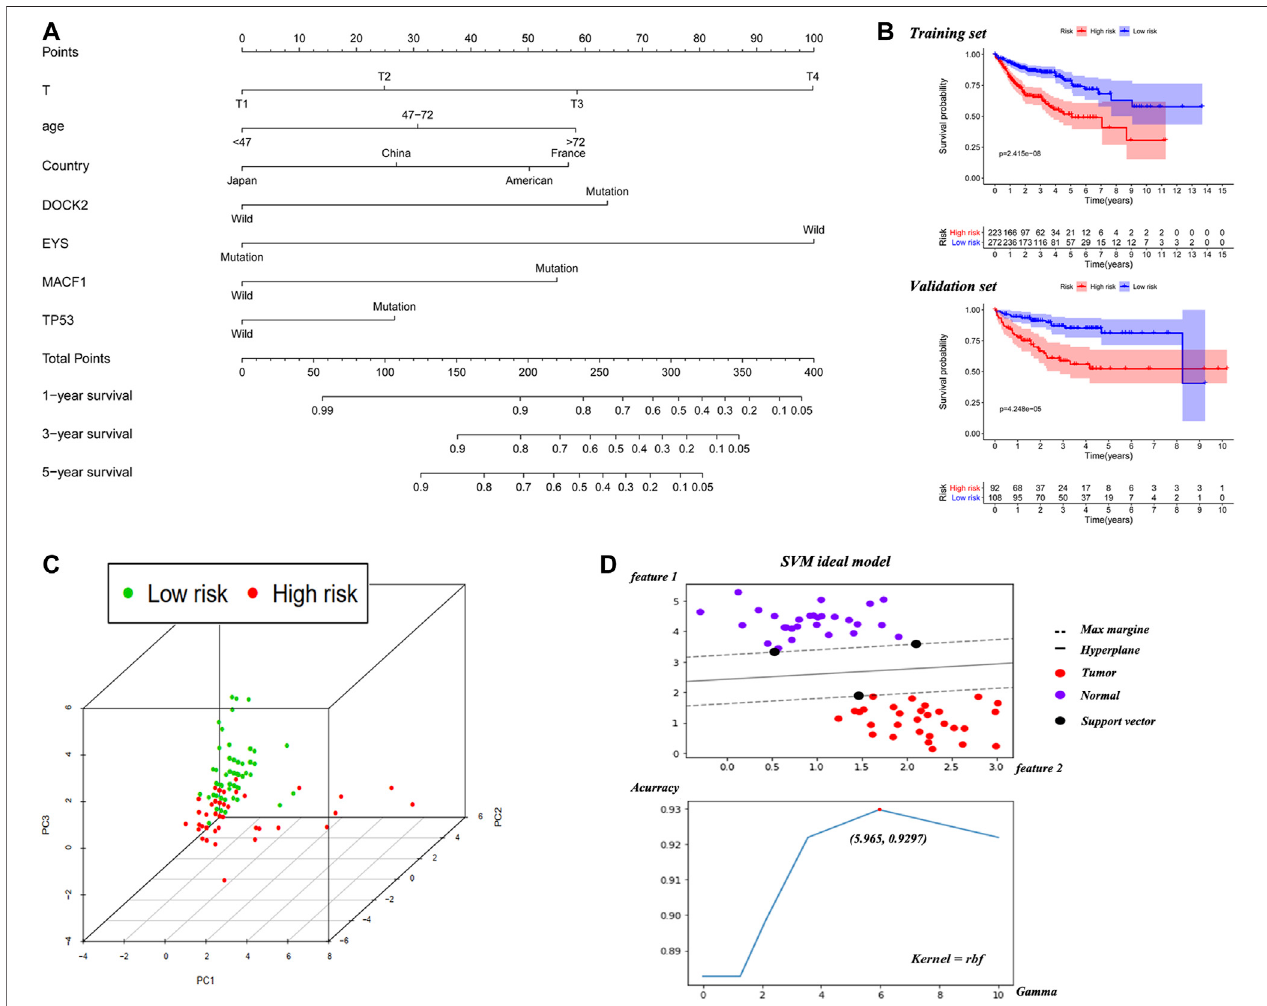
FIGURE 2| The nomogram based on training cohort and the ef fi cient evaluation oftraining and validation cohort. (A) Nomogram predicting 1-year, 3-years and 5- yearsOSforHCCpatientswithoutdistantandlymphaticmetastasis.Eachvariablehasacorrespondingscoreonthepointscale.Sumthescoreandlocateitonthetotal point axis. Then, draw a vertical line down to get the nomogram-predicted probability at each time point. (B) Kaplan-Meier curve of high-risk and low-risk HCC patients basedonthemedianofnomogramriskscoreinthetrainingandvalidationcohort. (C) Thevisualizationofhigh-andlow-riskpatients ’ distributionviaPCAalgorithm. (D) The schematic diagram of SVM and the adjusting progression to solve maximum accuracy of the